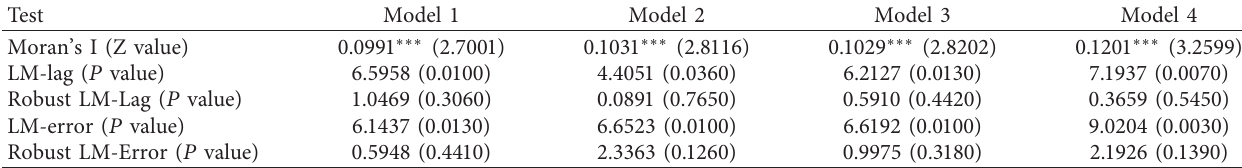
Table 4: Spatial autocorrelation test of FDI, regional corruption, and environmental pollution.